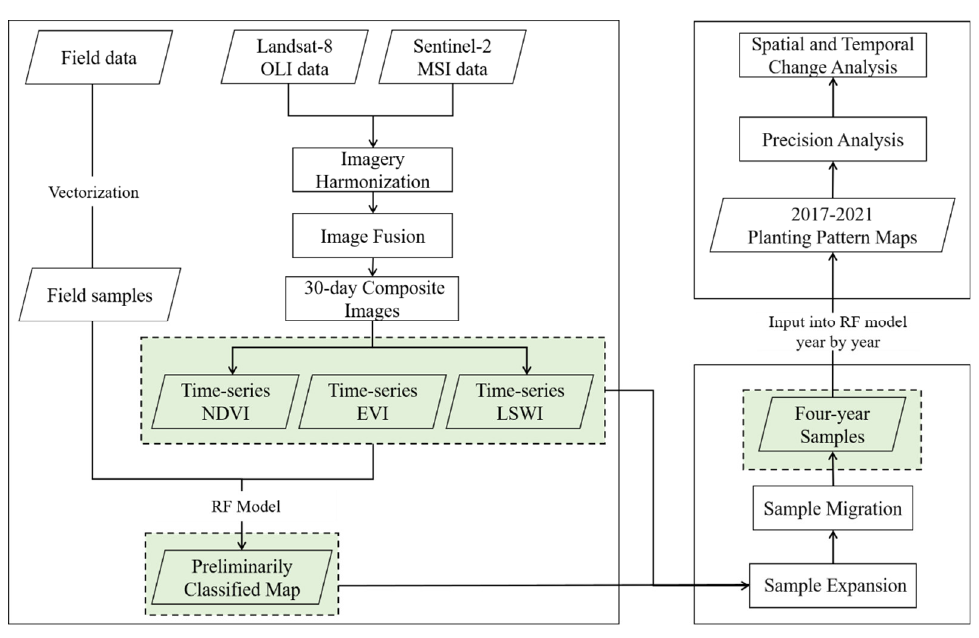
Figure 3. ( a – f ): Field images based on UAV observations and ( g , h ) photos of adjusting the UAV in the field and the field survey questionnaire.